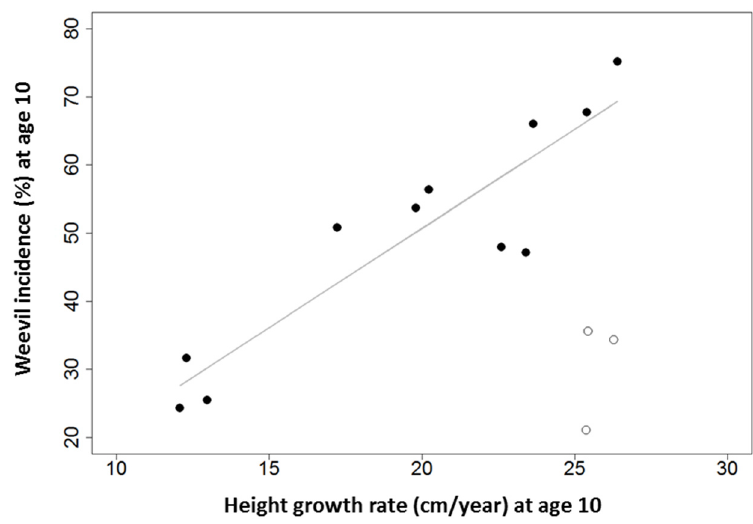
Figure 3. Relationship between treatment means for weevil incidence (%) and planted pine height growth rate (cm/year) at age 10 ( r = 0.91), observed at the ON clearcut site for treatments where the woody cover has been removed (solid circles). Treatments with woody cover still in place ( hhhh00 , hh0000 , and 000000 ; Figure 1) are not included in the correlation (hollow circles).